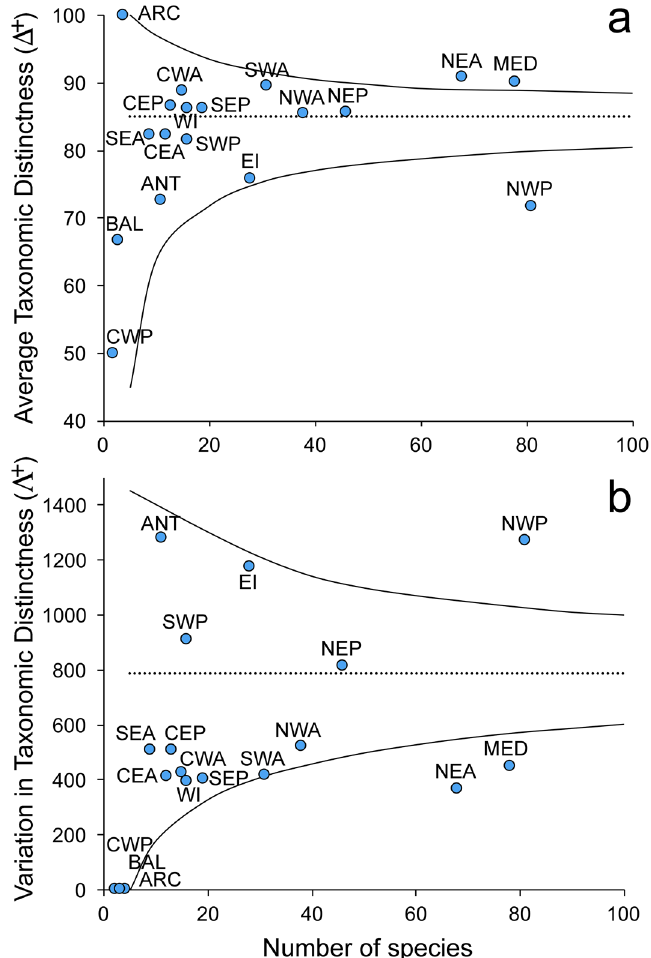
Figure 3. ( a ) Δ + values and ( b ) Λ + values of parasite assemblages recorded in each geographic area (circles), plotted against the corresponding total number of species. For both indices, the expected mean (dotted line) and the 95% confidence funnel (solid lines) were also plotted from 1,000 independent simulations of each subset ( m = 5, 10, 20…100) drawn randomly from the list of 309 parasites species recorded (see text for details). Analysis was done using the software package PRIMER v6 70